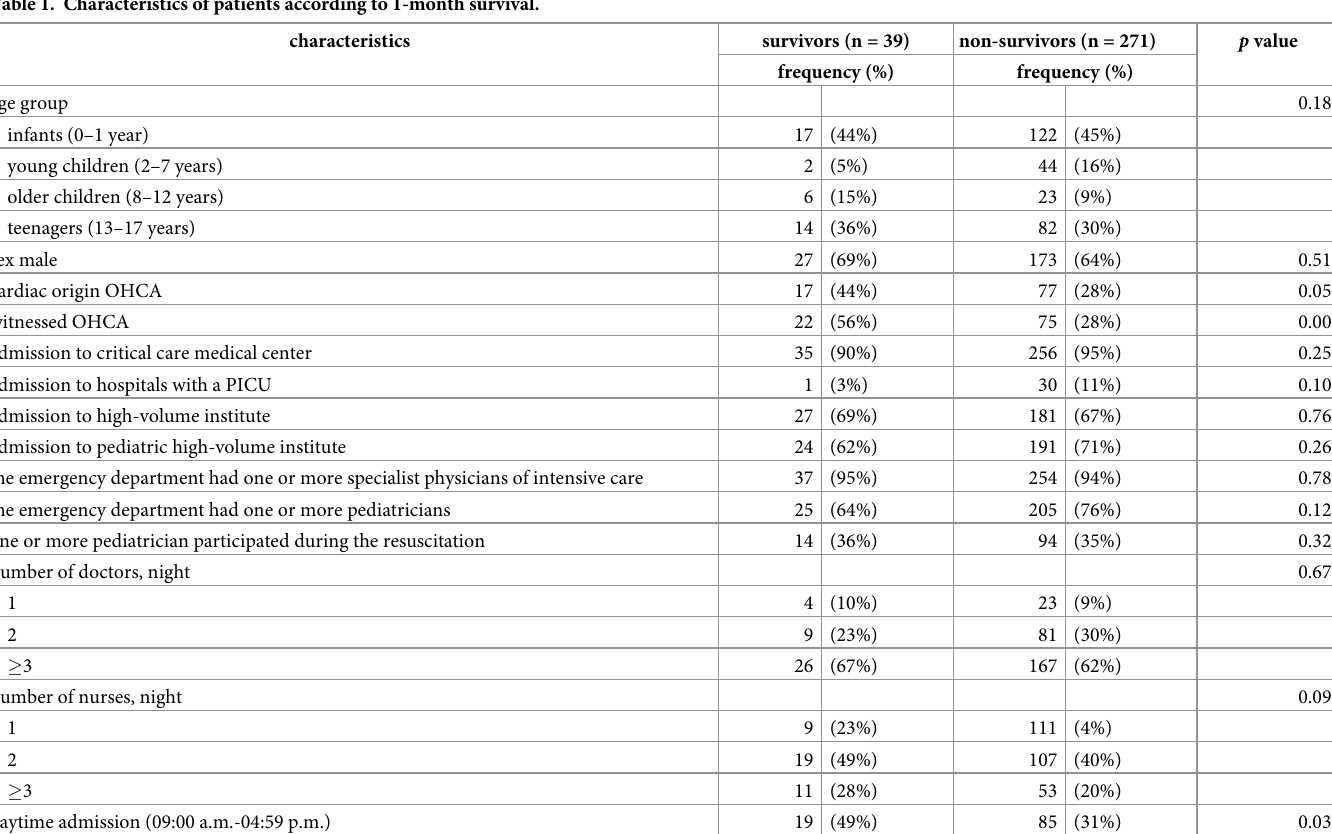
Table 1. Characteristics of patients according to 1-month